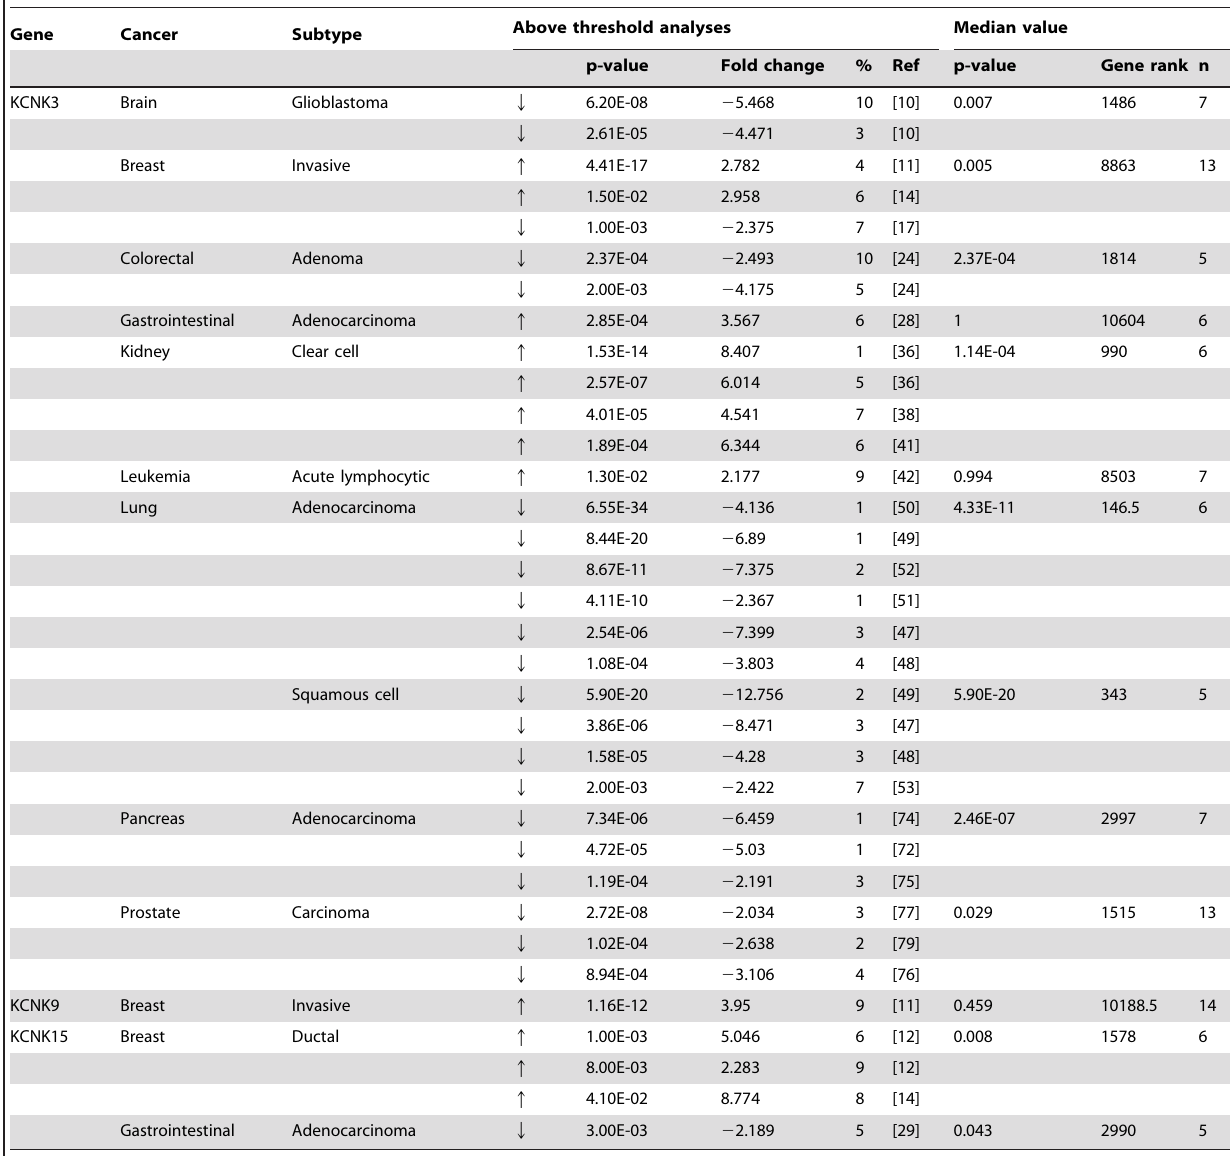
Table 4. TASK family members expression in cancer.